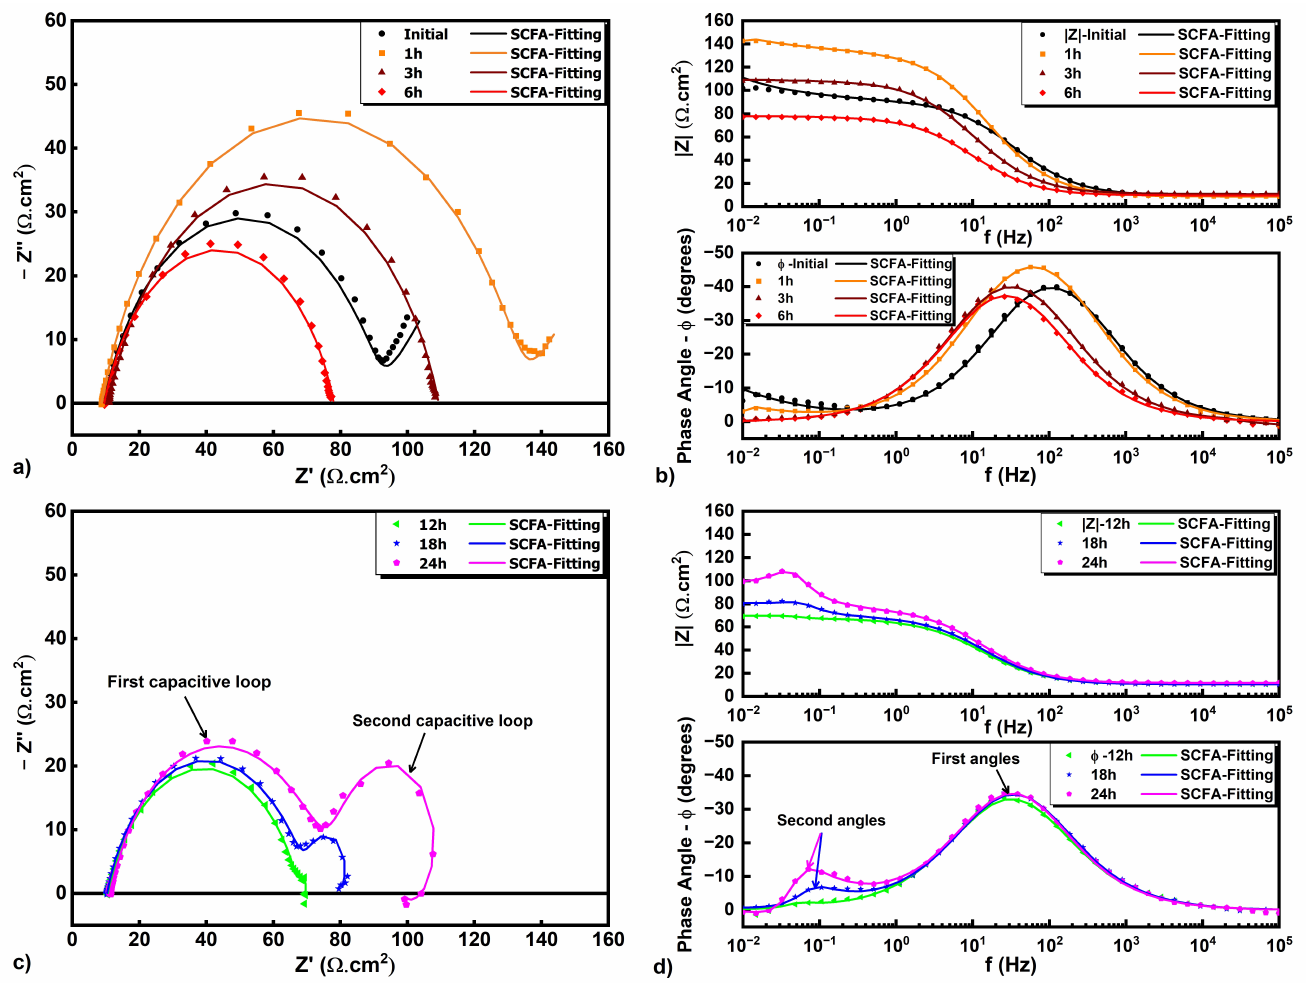
Figure 10. Electrochemical impedance spectrum in 0.25 M H 2 SO 4 solution at 25 ◦ C for the sample nitrided at f N2 of 0.5 at the initial time and after increasing immersion time: ( a , c ) Nyquist plot; ( b , d ) Bode plot